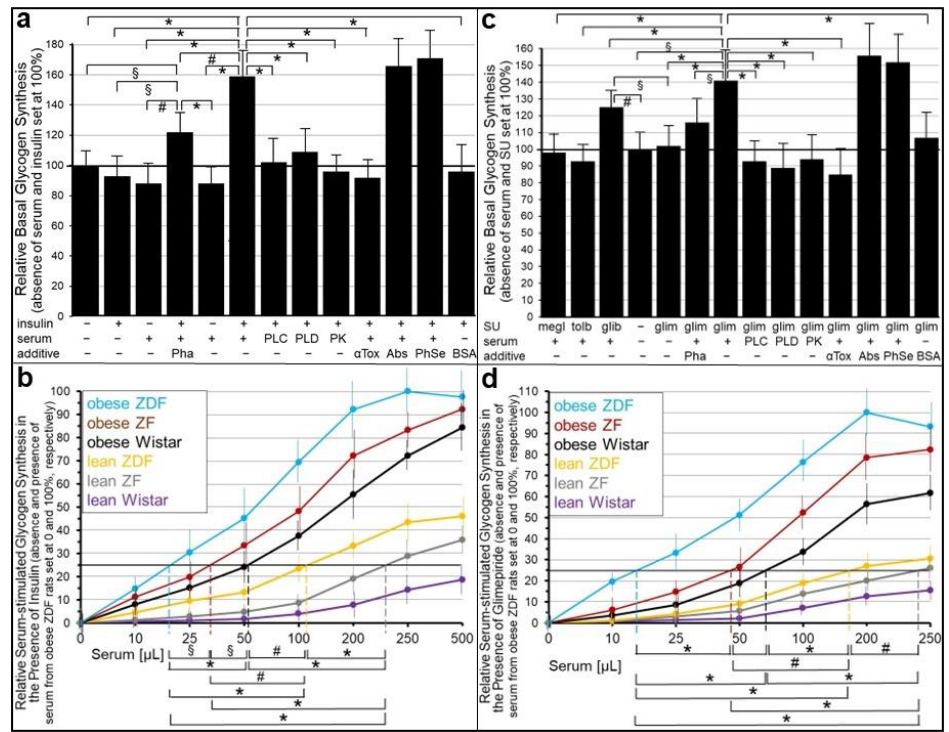
Figure 7. Stimulation of glycogen synthesis in ELCs by GPI-AP transfer in the simultaneous presence of serum and either insulin or SUs. ( a , c ) Human donor adipocytes (of lipid-loading stage II) were incubated (1 week, 37 °C, 5 mM glucose) with GPI-deficient EL acceptor cells in the insert and bottom wells, respectively, of transwell co-cultures in the absence or presence of human insulin (30 nM), meglitinide (megl, 50 μM), tolbutamide (tolb, 1 mM), glibenclamide (glib, 30 μM) and glimepiride (glim, 30 μM) without or with 200 μL serum, which were prepared from obese ZDF rats and then diluted 10-fold with PBS containing 2 mM Pha, or BSA (4 mg/mL PBS) in the presence of 4 mM Ca 2+ or 1 mM Pha, as indicated ( a , c ). The serum was left untreated or digested with bacterial PI- PLC (PLC), human GPLD1 (PLD) or proteinase K (PK) or supplemented with α - toxin (αTox) or antibodies against TNAP, CD73 and AChE (Abs), each coupled to Sepharose beads or phenyl Se- pharose beads (PhSe) prior to addition to the transwell co-cultures. ( b , d ) The transwell co-cultures were run as above without or with increasing volumes of untreated serum, which were prepared from lean or obese Wistar, ZF or ZDF rats under the inclusion of Pha (2 mM), in the presence of insulin (30 nM) ( b ) or glimepiride (30 μM) ( d ). Thereafter, the ELCs in the bottom plate were assayed for glycogen synthesis (15 min, 37 °C, presence of BSA, 0.1 mM [U- 14 C]glucose), as described in Section 4. The transwell co-cultures were repeated three to five times (distinct co-cultures) with de- termination of glycogen synthesis in triplicate. ( a , c ) The relative glycogen synthesis is given with the absence of serum and insulin ( a ) or SUs ( c ) set at 100% (horizontal, black lines). Significant dif- ferences are indicated. ( b , d ) The relative serum-stimulated glycogen synthesis in the presence of either insulin ( b ) or glimepiride is given, with the absence and presence of serum (250 and 200 μL, respectively) from obese ZDF rats set at 0 and 100%, respectively. Serum volumes (EV 25 ) effective in the 25% stimulation of glycogen synthesis (horizontal, black lines) in the presence of either insulin ( b ) or glimepiride ( d ) are indicated by the vertical, hatched, and colored lines. Significant differences between EV 25 for sera from rats of different metabolic states are indicated (means ± SD; * p ≤ 0.01, # p ≤ 0.02, § p ≤ 0.05).